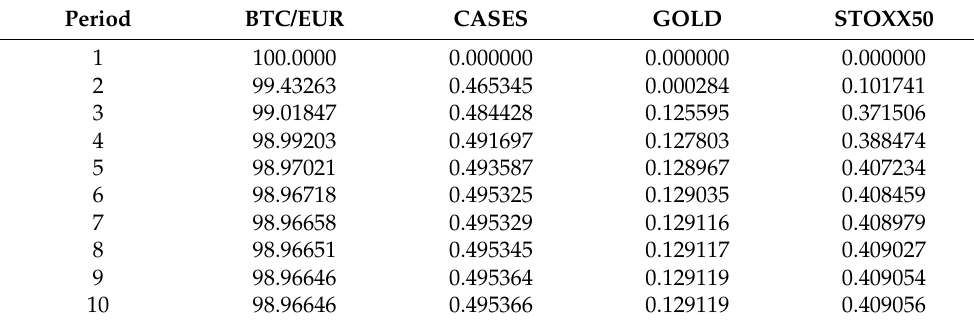
Table 3. Variance decomposition of BTC/EUR.